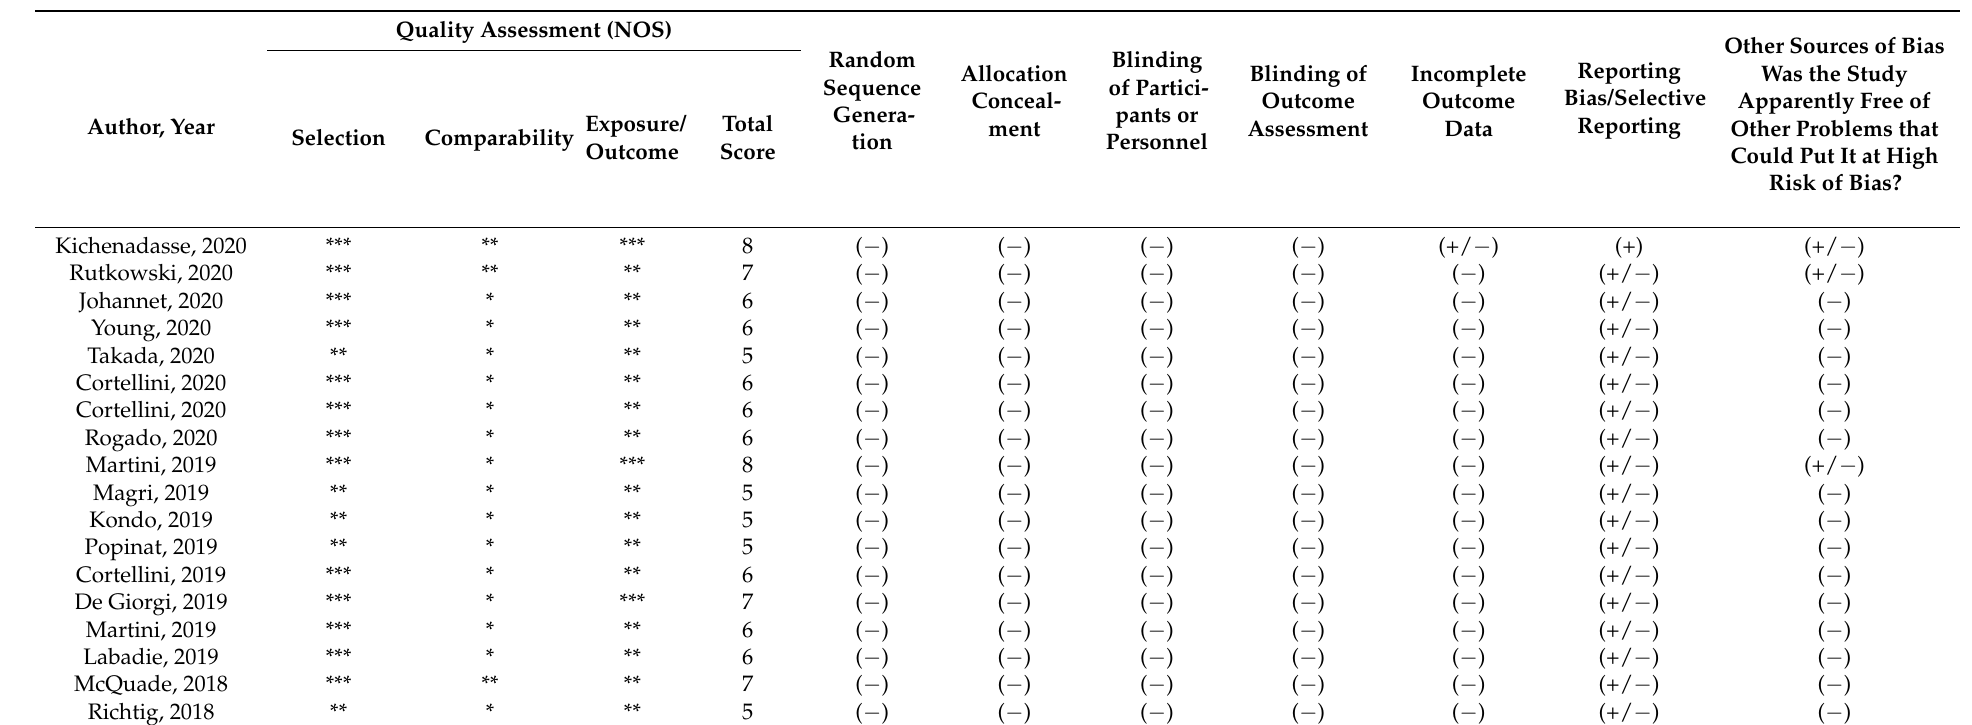
Table 2. Quality and risk of bias assessment of the analyzed